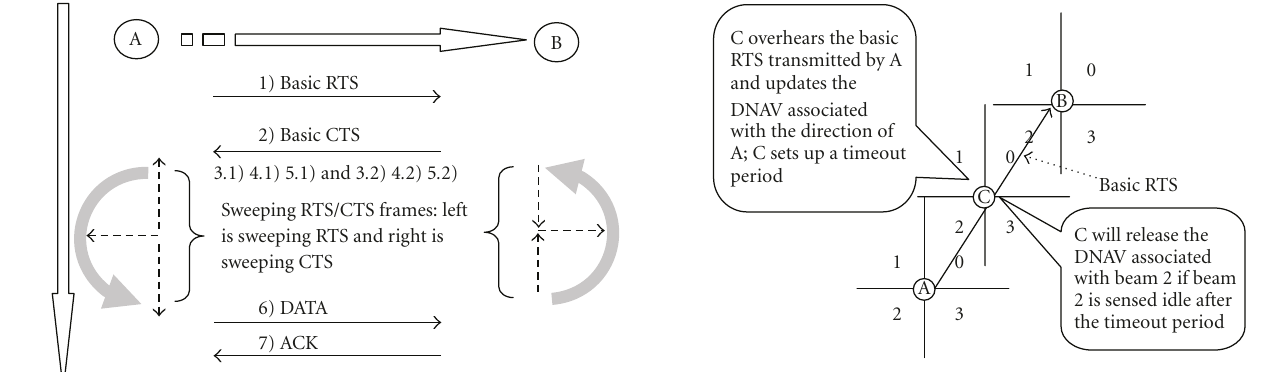
Figure 9: DMAC-DACA handshakes.